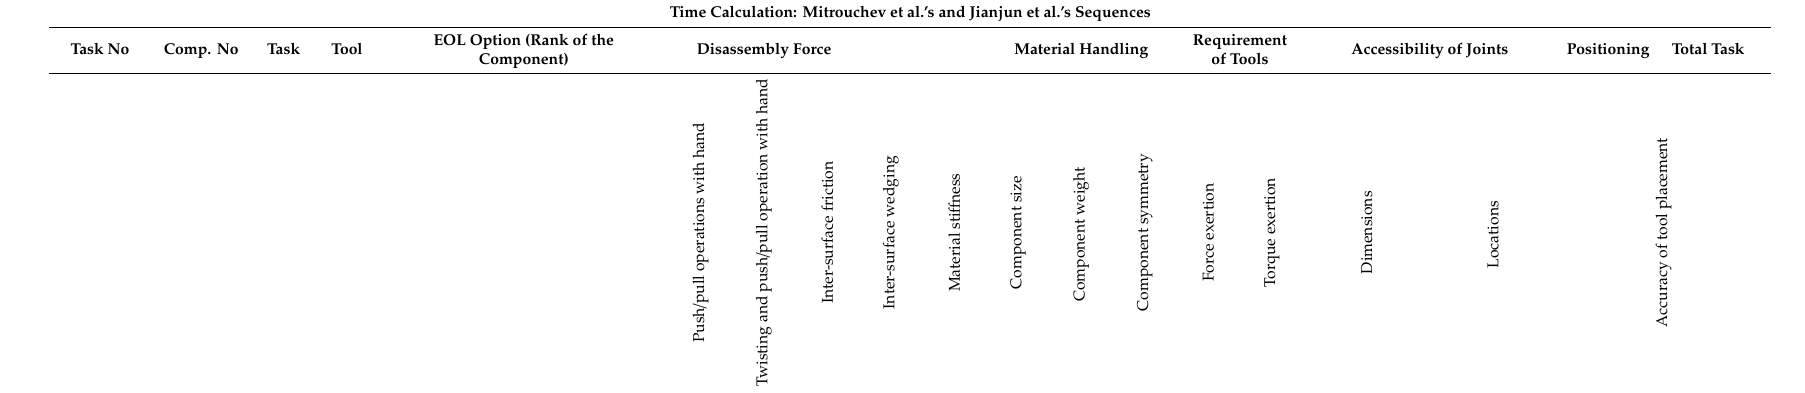
Table 2. The structure of data collection for Mitrouchev et al.’s and Jiaunjun et al.’s disassembly sequences. Time Calculation: Mitrouchev et al.’s and Jianjun et al.’s